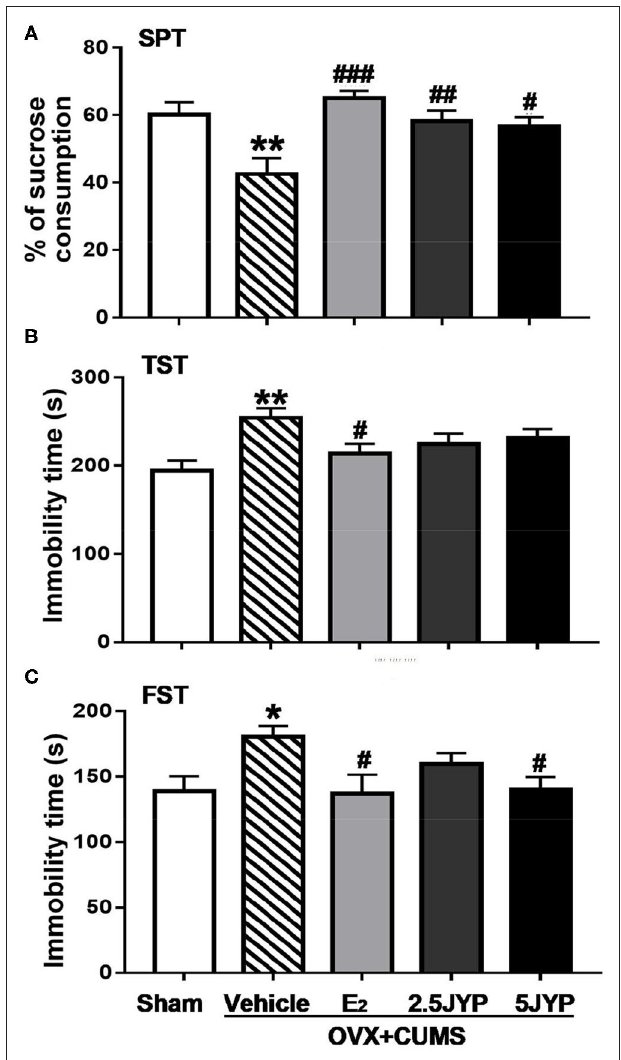
FIGURE 4 | Effects of 2.5 g/kg JYP (2.5 JYP), 5.0 g/kg JYP (5 JYP), and 0.3 mg/kg estradiol (E2) on OVX + CUMS-induced depression-like behavior: (A) percentage of sucrose consumption in sucrose preference test (SPT); (B) immobility time of tail suspension test (TST); and (C) immobility time of forced swimming test (FST). Data are expressed as mean ± SEM ( n = 9–10) and examined with one-way analysis of variance (ANOVA), followed by post hoc between-group comparisons: * P < 0.05, ** P < 0.01 vs. sham group; # P < 0.05, ## P < 0.01, ### P < 0.001 vs. vehicle